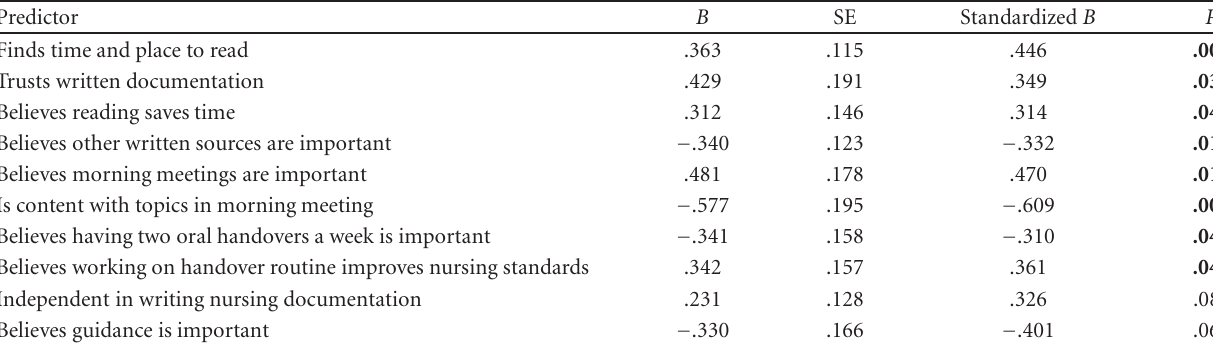
Table 2: Predictors of satisfaction with new handover